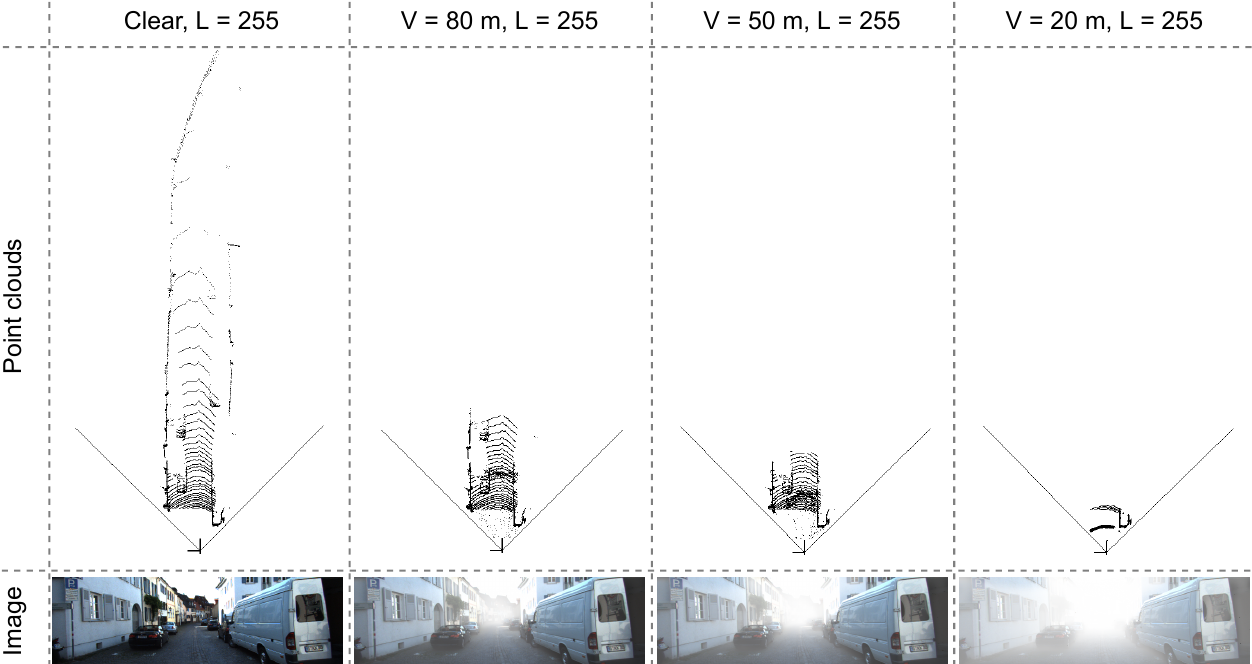
( a ) From left to right, image and point cloud are shown for “Clear” sample and simulated fog samples (64-beam) through different levels of visibility. Point clouds are shown in bird’s eye view (BEV) representation. 64-beam point clouds are used here to more clearly Figure 2. Cont